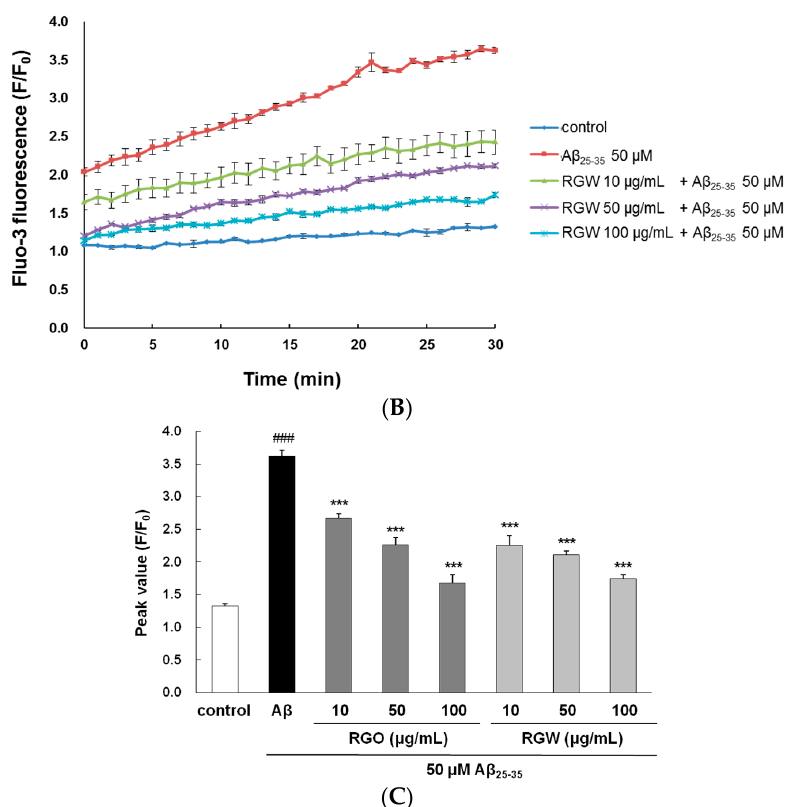
Figure 4. RGO ( A ) and RGW ( B ) ameliorated A β 25–35 -induced intracellular calcium levels ([Ca 2+ ]i). Histogram showing the peak values of [Ca 2+ ]i ( C ). The graph indicates calcium levels the as described in Materials and Methods. ### p < 0.001 compared to control group; *** p < 0.001 compared to A β 25–35 alone (ANOVA followed by Duncan’s multiple comparison test).